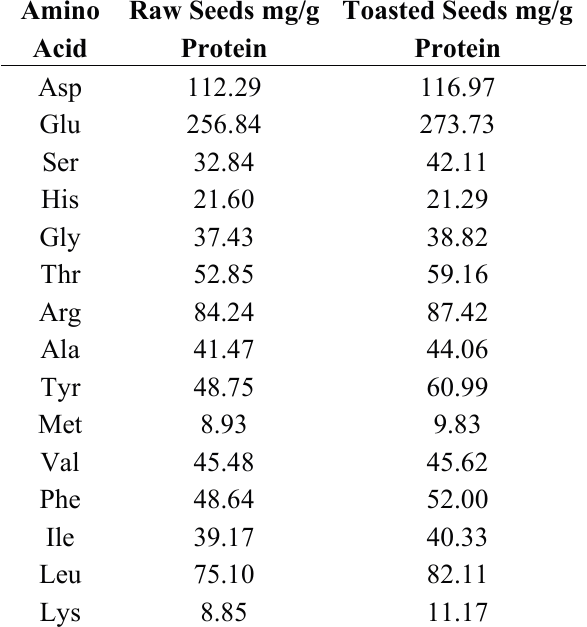
Table 3. Protein amino acids composition of raw and toasted black cherry